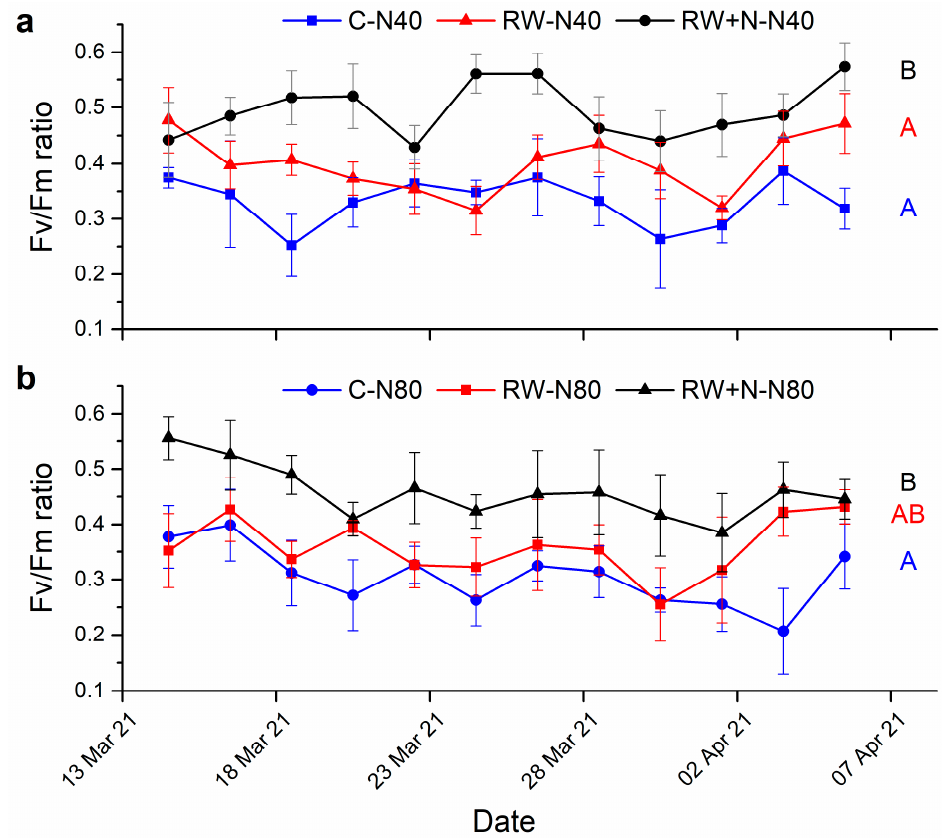
ment for both 40 and 80 kg N h − 1 y − 1 (Figure 3, Table 2). Long-term N addition significantly both 40 (Figure 3a) and 80 (Figure 3b) kg N h − 1 y − 1 : RW+N samples showed the highest vitality values. Control samples had the lowest values while RW samples were intermediate (Figure 3a,b). Nitrogen load had no significant effect. Fv/Fm values did not follow any particular pattern over time for any treatment (Figure 3a,b).